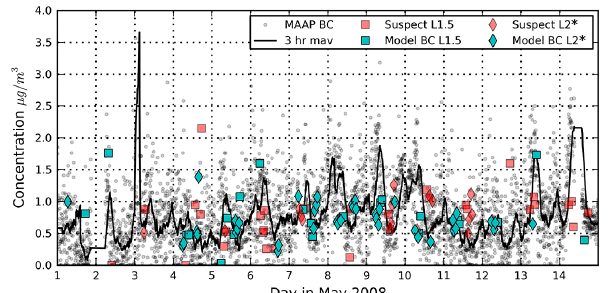
Figure 8. Time series of black carbon concentration from surface observations (multi-angle absorption photometer, black dots) with 3h centered moving average (black line), and our model results (L1.5: turquoise squares; L2 ∗ : turquoise diamonds; suspect: